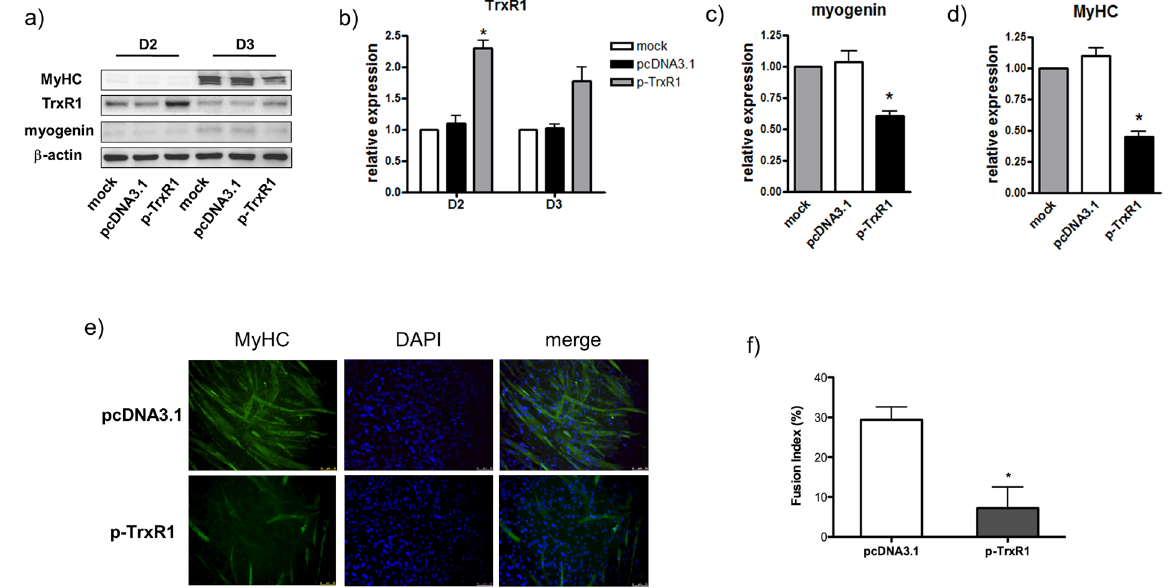
Figure 3. TrxR1 overexpression delays C2C12 differentiation. C2C12 were transfected or not (mock) with p-TrxR1 or the empty vector pcDNA3.1 and analysed at 48 (D2) and 72 hours (D3) from differentiation induction. ( a ) Representative image of the western blot analysis showing the protein expression of TrxR1, Myogenin, MyHC and β -actin. The amount of TrxR1 ( b ), Myogenin ( c ) and MyHC ( d ) in each sample was calculated by normalizing to β -actin protein levels. Results are represented as mean ± SEM of at least three different experiments. The ratio of mock sample was set = 1. ( e ) Representative image (20x magnification) of the immunofluorescence analysis showing MyHC expression at D3 of differentiation. DAPI staining was used to detect nuclei. ( f ) Fusion index relative to D3 calculated in at least five random microscopic